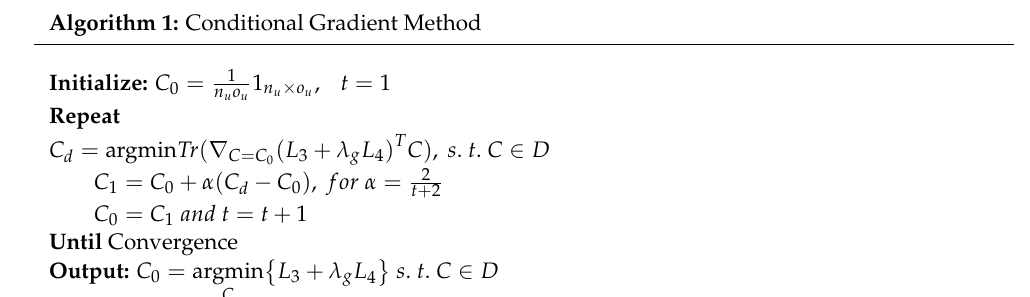
Algorithm 1. using the Simplex Formulation [44] in EMD [45], the variable C d in Algorithm